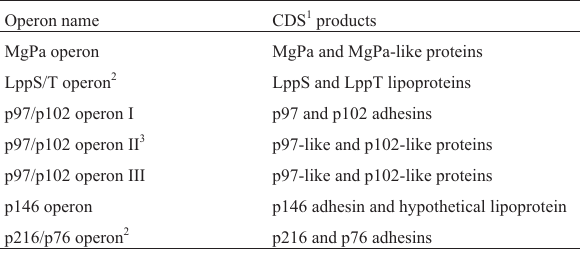
Table 2 -Putative cythaderence-related operons in the M. hyopneumoniae